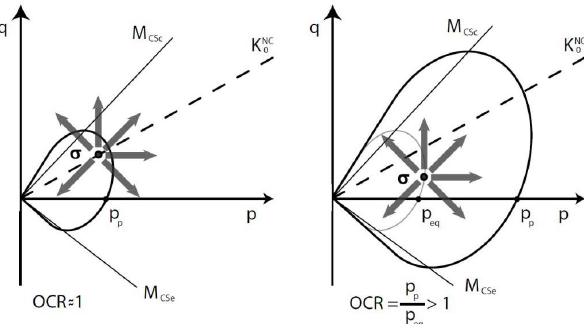
Figure 13: In situ stress state in NC (or slightly OC) and OC soil.